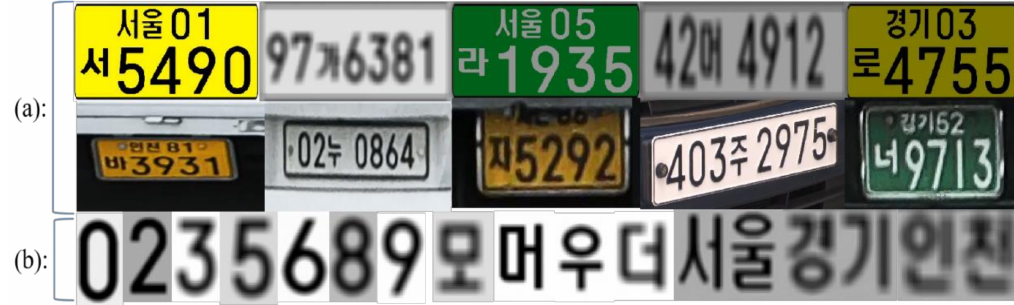
Figure 1. Sample images from two sets of data, which include ( a ) whole LP images and ( b ) single-character